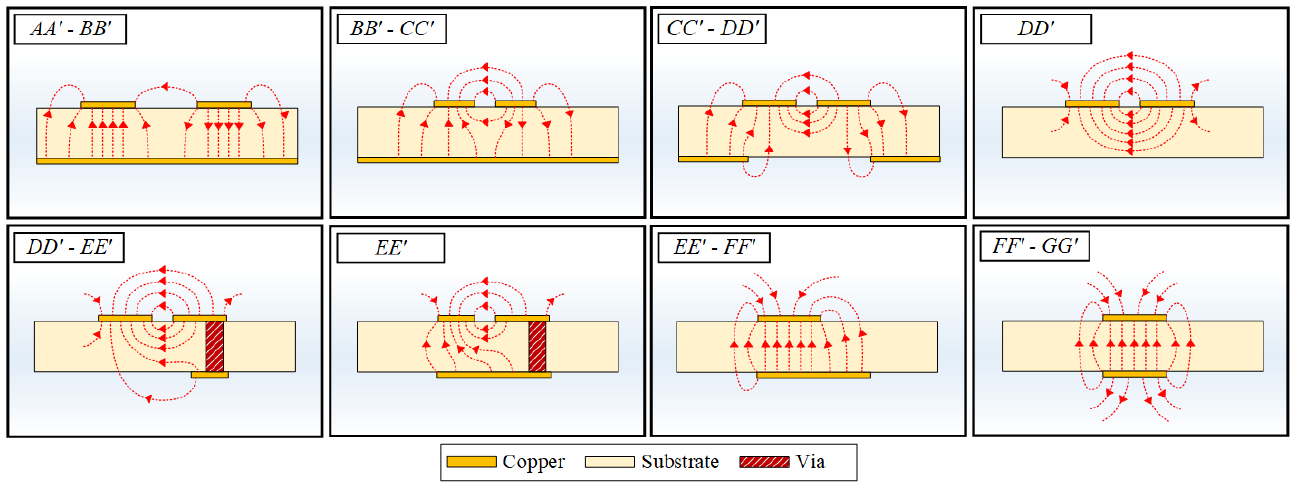
Figure 14. Electric field distributions of the cross-sectional stages of the DL-to-PSL transition.